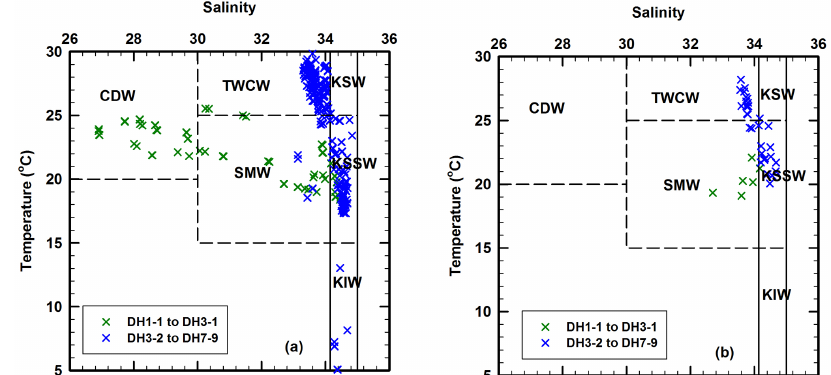
Figure 6. Temperature–salinity ( T – S ) diagrams for (a) the entire water column in the East China Sea and (b) the deep chlorophyll maximum layer where the suspended particulate matter were collected for the present investigation. T – S ranges of six water masses are taken from Umezawa et al. (2014). CDW – Changjiang Diluted Water; TWCW – Taiwan Warm Current Water; SMW – Shelf Mixed Water; KSW –